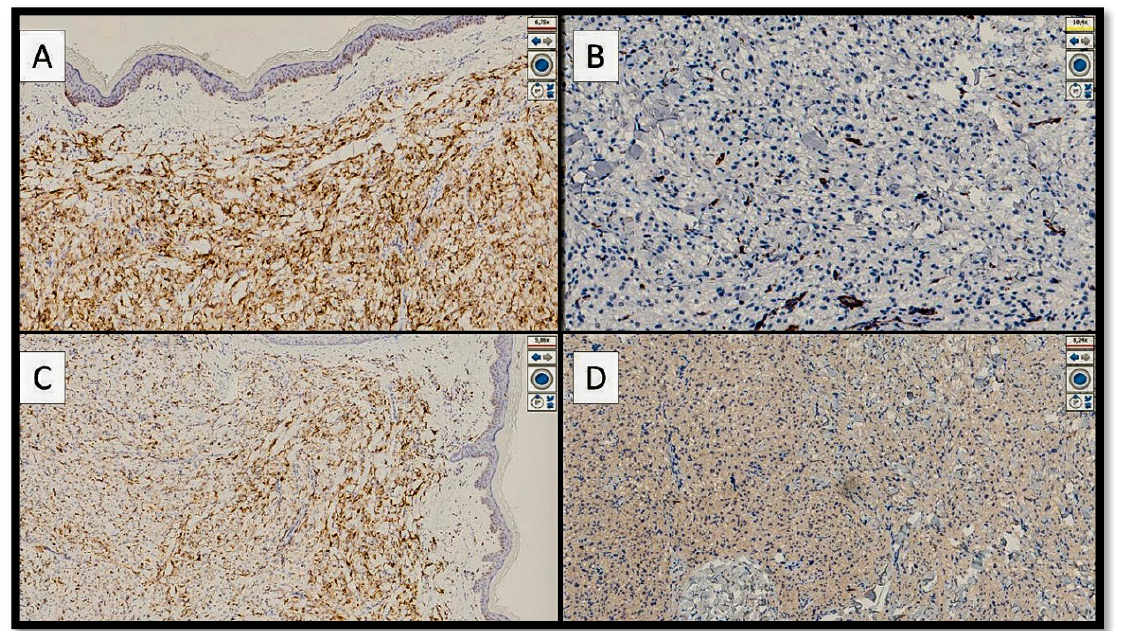
Figure 3. ( A ) Immunostaining photomicrograph with anti-HMB-45 antibody. Note the widespread and intense positivity of the clear epithelioid cells of the cPEComa (immunostaining for HMB-45, original magnification: 10×). ( B ) Immunostaining micrograph with anti-smooth muscle actin anti- body. Note the almost complete negativity, with partial positivity of some elements (red arrows) (original magnification: 20×). ( C ) Photomicrograph shows positivity of CD68 (PGM-1) histiocytes accompanying the lesion (original magnification: 10×). ( D ) Photomicrograph shows almost com- plete negativity for desmin, with the focal and discontinuous positivity of some elements (original magnification: 20×).